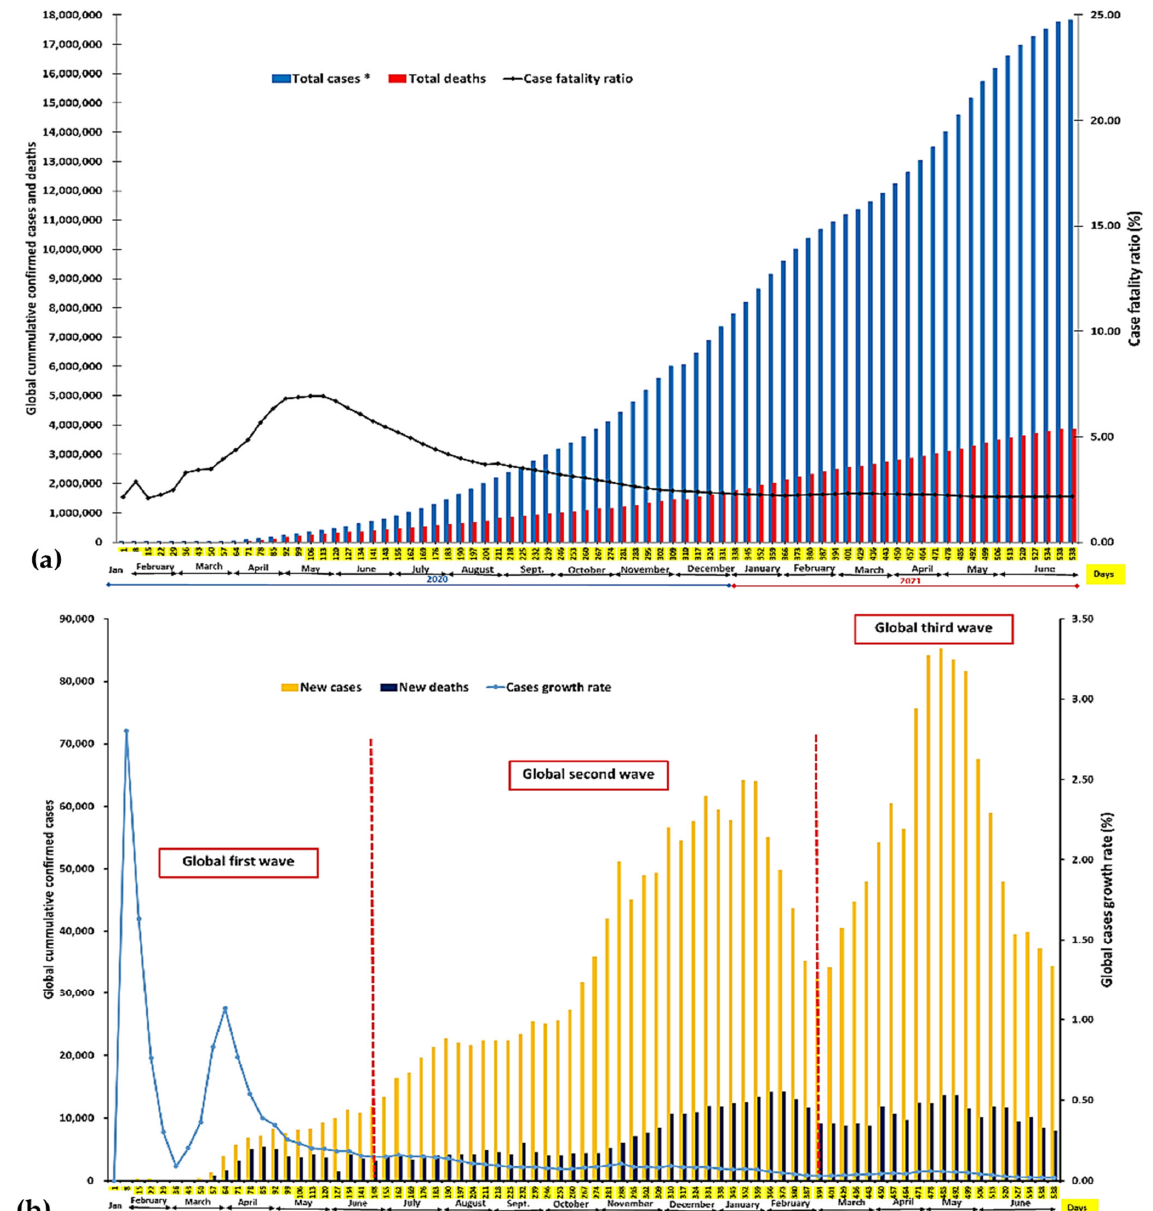
Figure 2. ( a ) Temporal global COVID-19 cumulative cases, cumulative deaths, and CFR based on WHO data of 21 June 2021. * Actual values have been adjusted downwards by 10 units to fit both data into the y-axis. ( b ) Temporal global COVID-19 daily new cases, daily new deaths, and daily case growth rate based on WHO data of 21 June 2021. Daily deaths within the third wave were higher than those observed within the first wave. The growth rate of new cases rose sharply in late February but fell steadily through the beginning of March. The growth rate peaked between 20 and 23 March 2020 and began to fall again through the end of March 2020, April, and May 2020. The daily case growth rate also showed a slight increase at the start of each wave experienced during the period. However, the daily growth rate in new cases remained lower in June 2021 than at any time since the pandemic began.